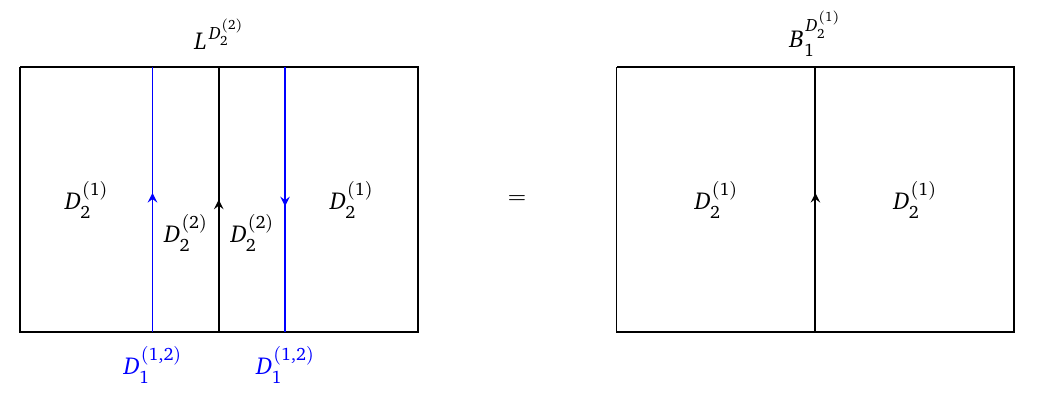
D p 2 q 2 living on D p 2 q and 1 2